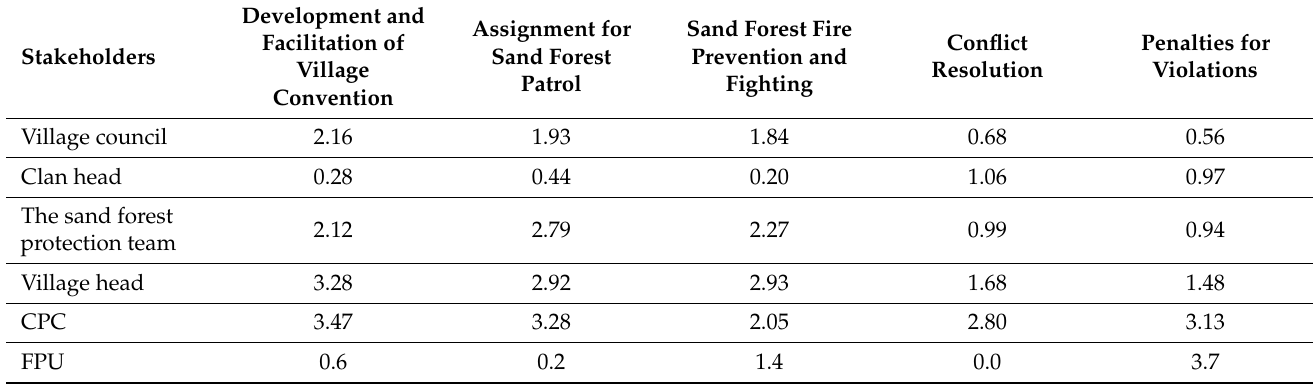
Table 4. Local people’s perceptions of stakeholders’ roles in sand forest